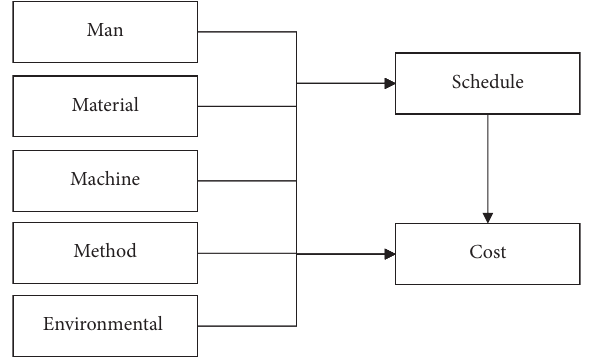
Figure 1: Framework of risk identification and risk loss for COVID-19 towards tunnel